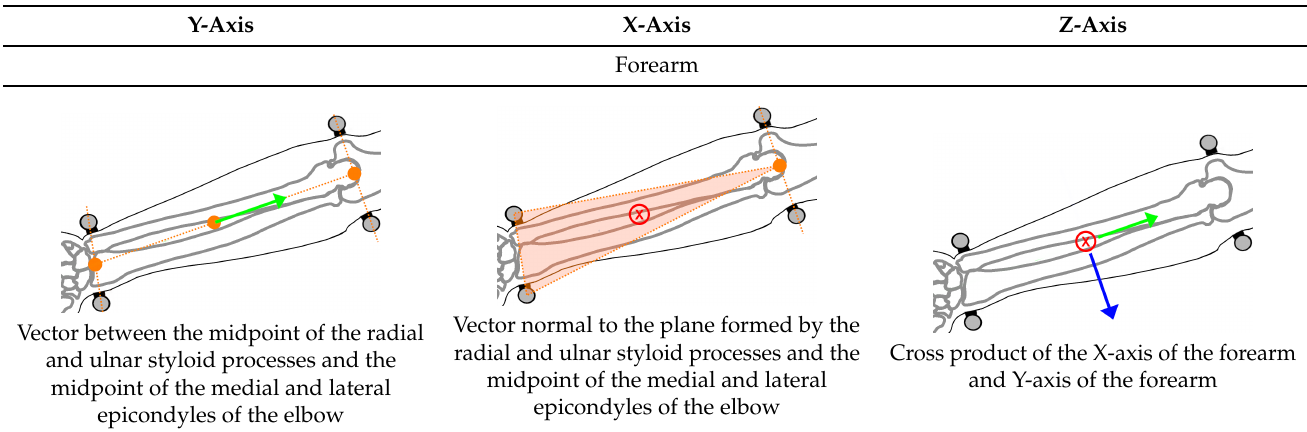
Table 1. Definitions of the forearm and hand coordinate systems used to calculate wrist angles, orange markers indicate calculated midpoints, X-axes point